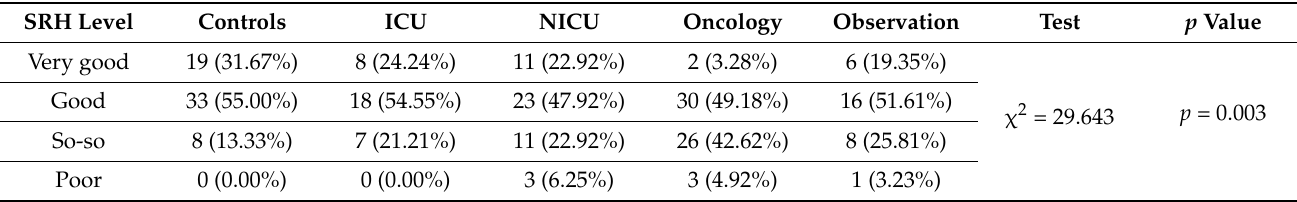
Table 3. A comparison of the groups distinguished according to the place of hospitalization of the child with respect to self-rated health.